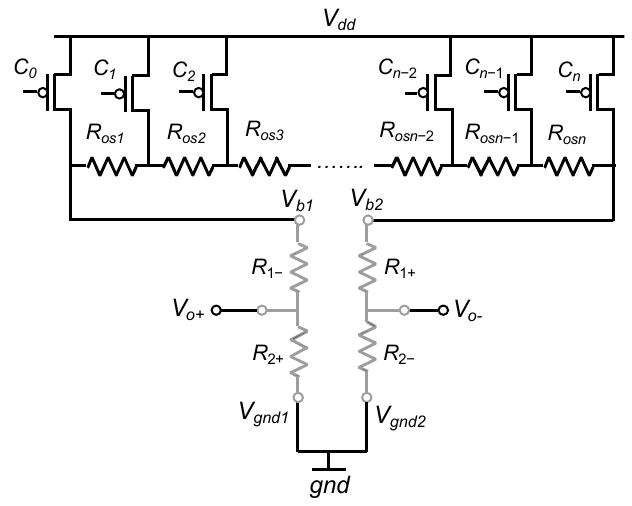
Figure 3. Basic architecture for offset compensation.